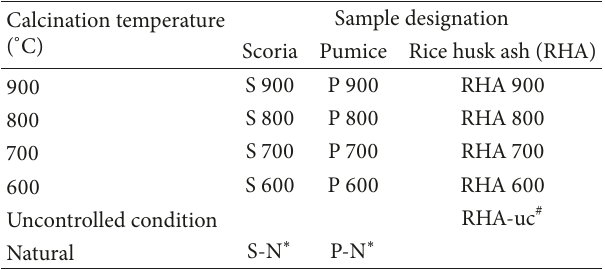
Table 2: Sample designation and